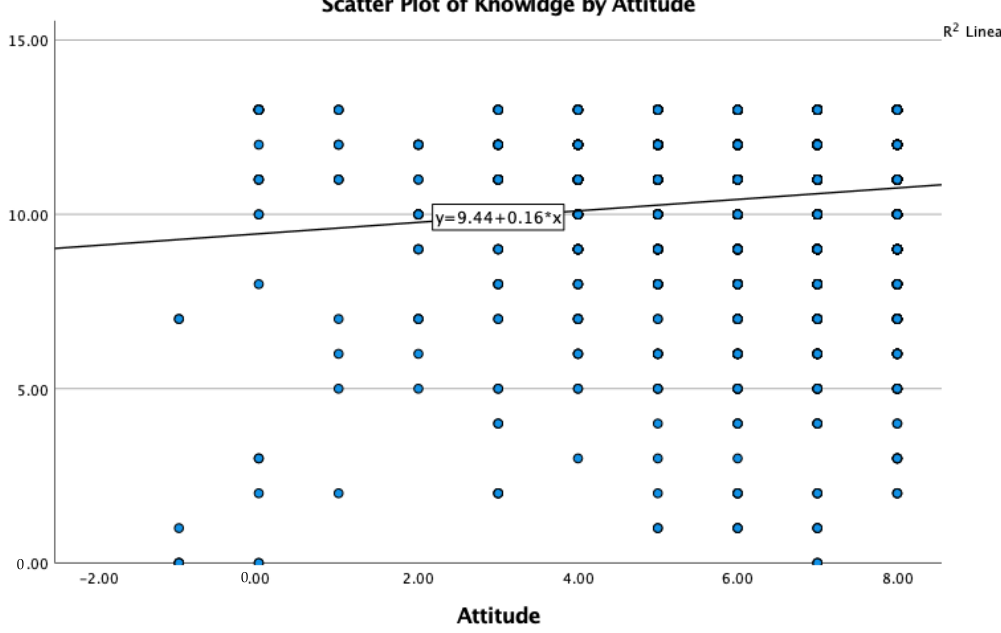
Figure 2. Knowledge and attitude of the target population also showed a negligible positive associ- ation. Table 6. Association of the Spearman correlation between knowledge and attitude.